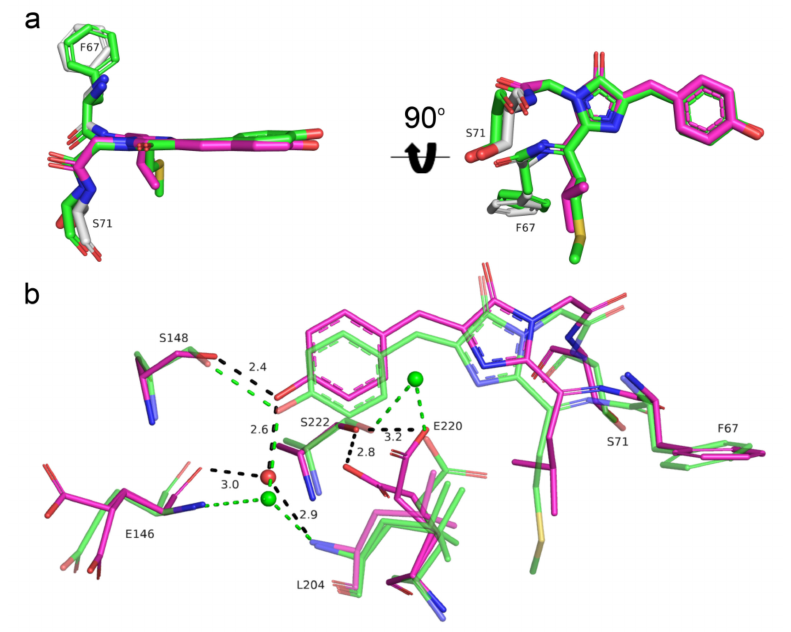
Figure 8. Structural comparison of the chromophores ( a ) and their immediate environments ( b ) for the red form of the mRubyFT (magenta) and red form of the Fast-FT timer (PDB ID: 3LF3, green). Water molecules (red or green spheres) and hydrogen bonds (dashed lines) are shown. Hydrogen bond distances are only labelled for mRubyFT for clarity. Residues’ enumeration is shown for the mRubyFT protein. In panel ( a ), the orientation of the chromophore on the right is rotated 90 ◦ around the horizontal axis with respect to that on the